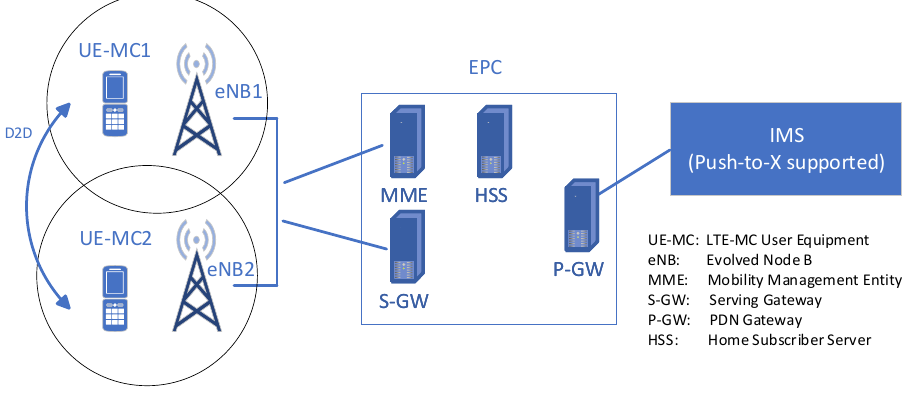
Figure 2. LTE-MC